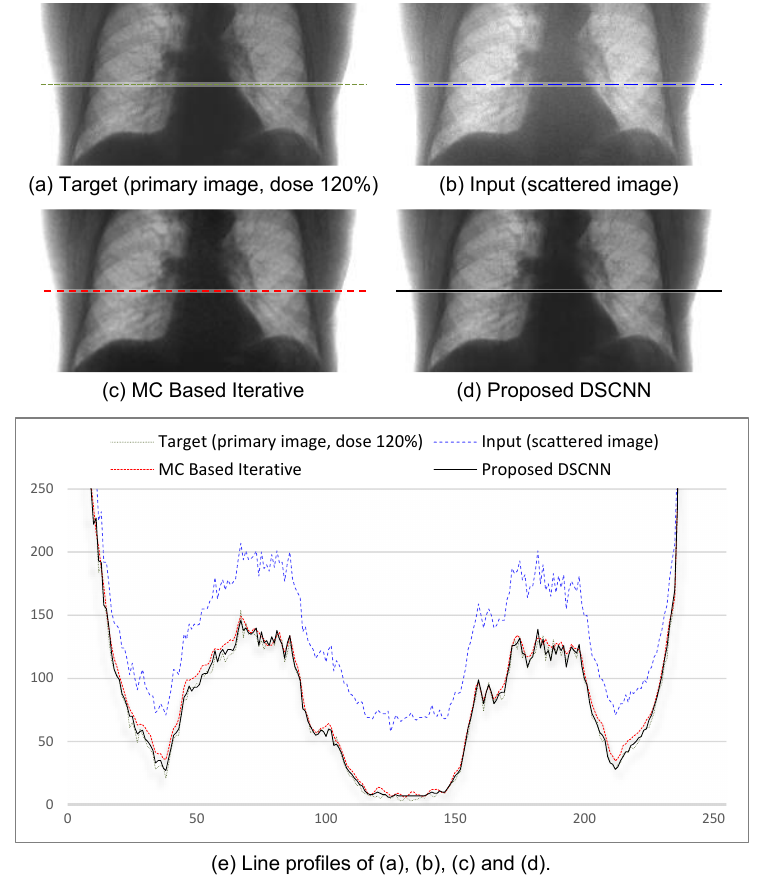
Figure 8. Comparison of scatter-corrected images and line